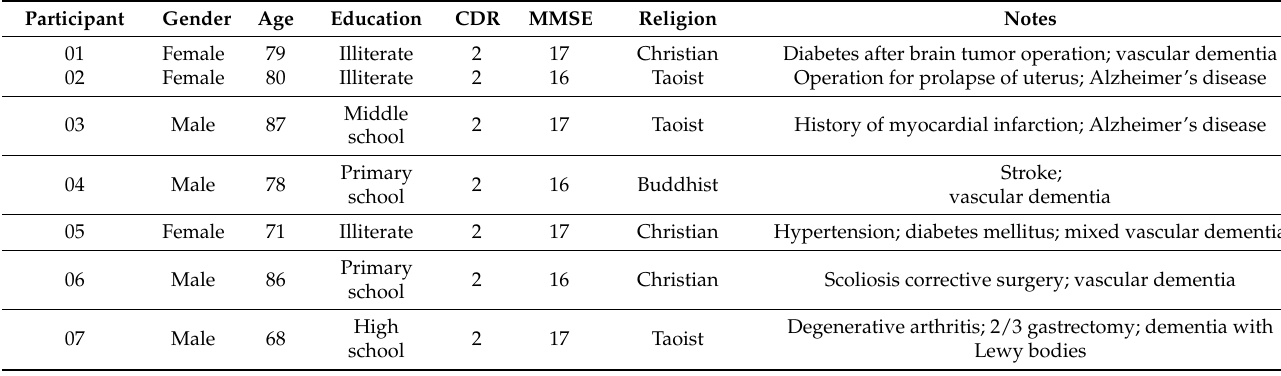
Table 1. Demographic data of